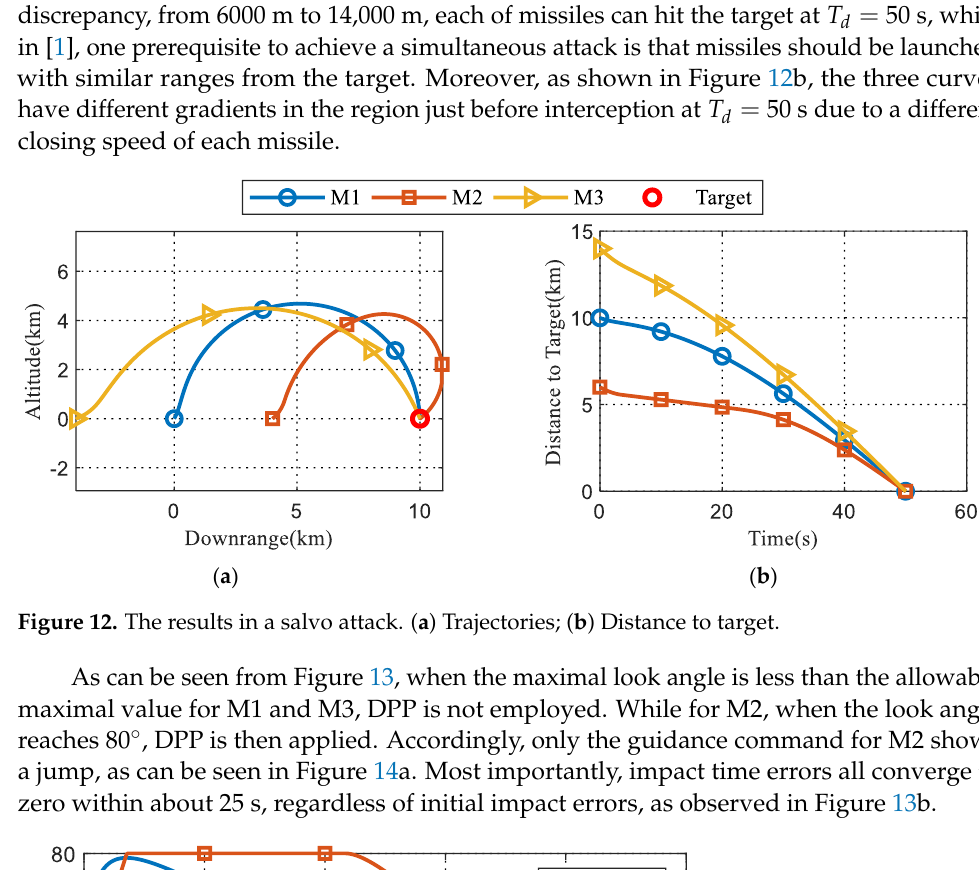
Figure 13. Look angles in a salvo attack.